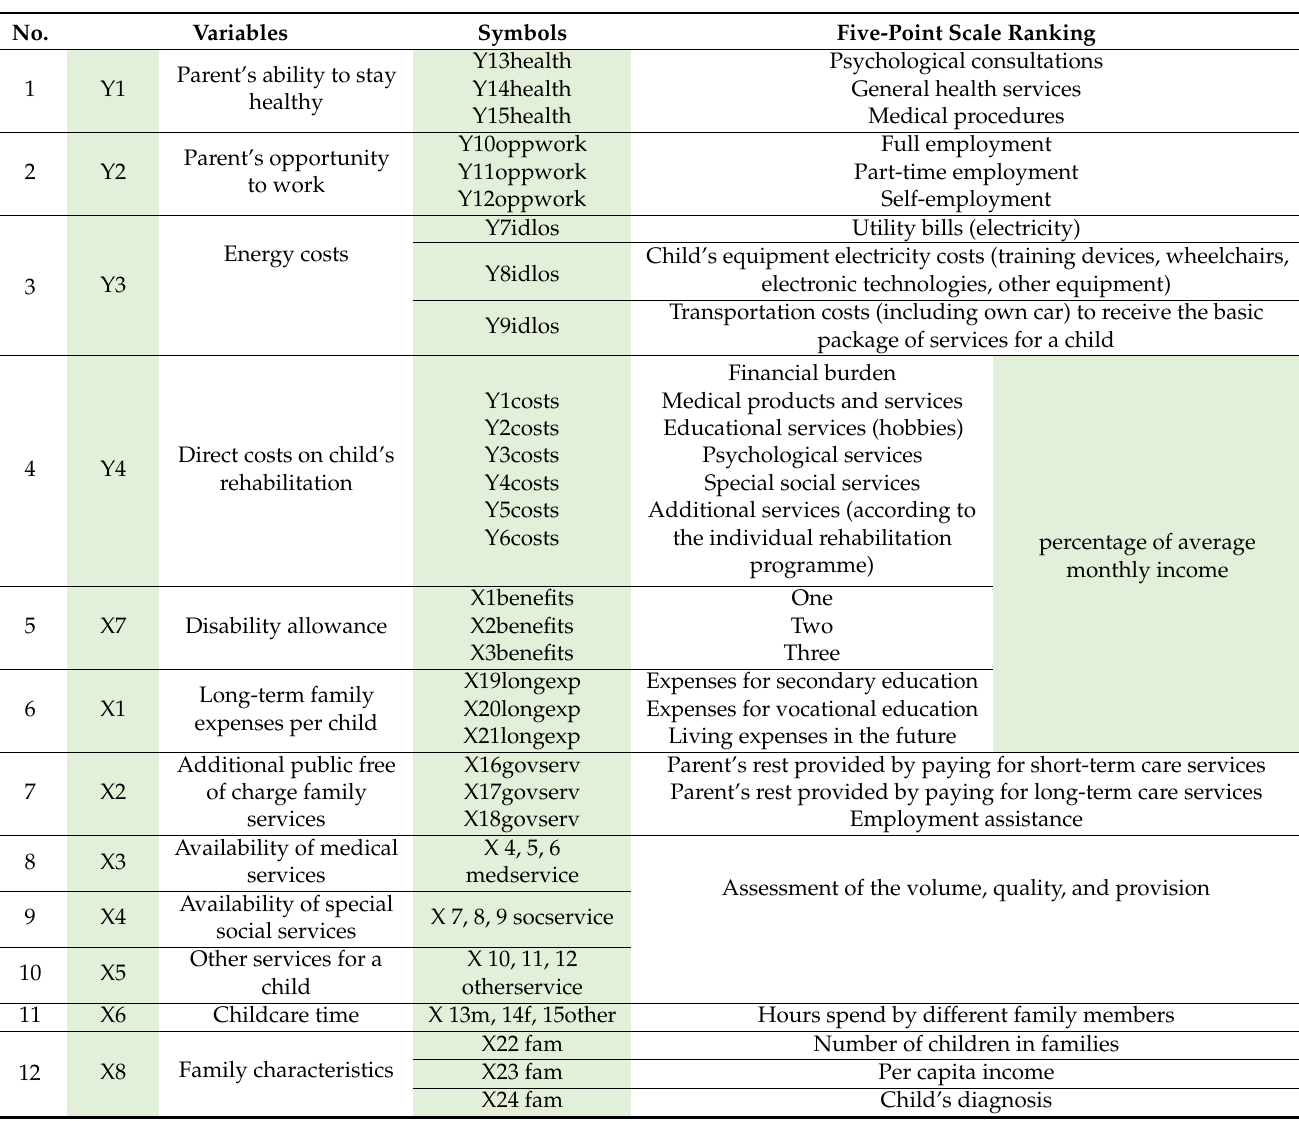
Table 1. Questionnaire structure and symbols of latent variables Y n and observed variables X m in the PLS–PM